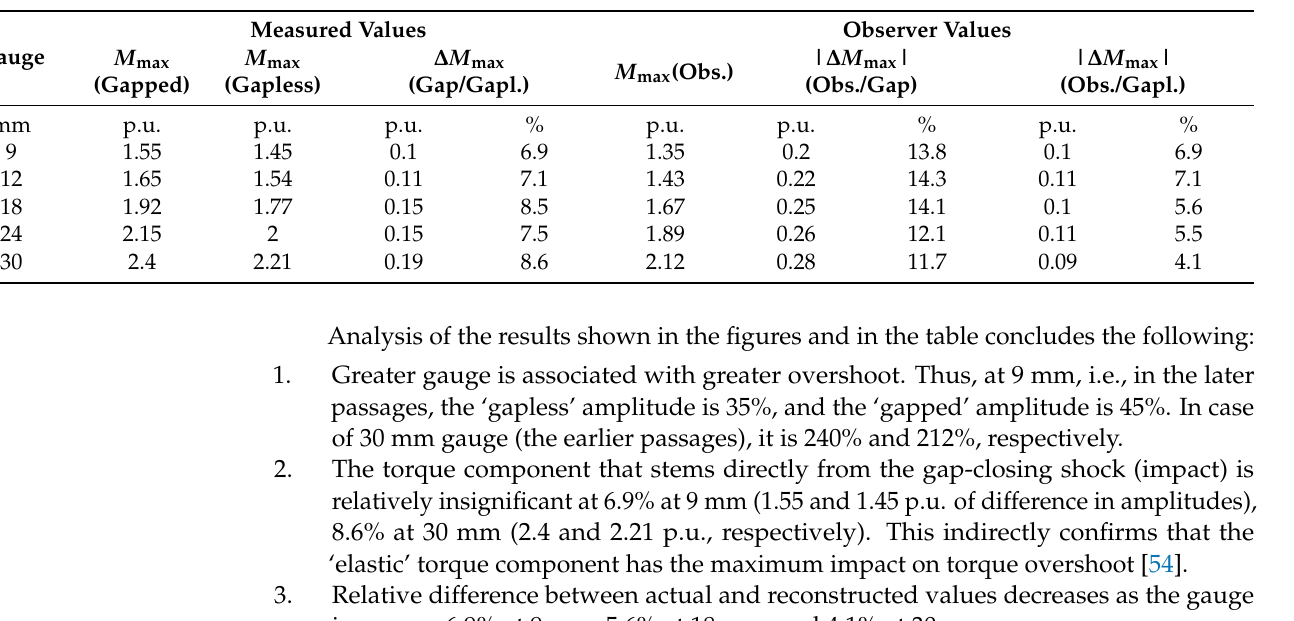
Figure 15. Charts of maximum gripping torque: experimental vs observer reconstructed. Table 2. Calculated gripping torque